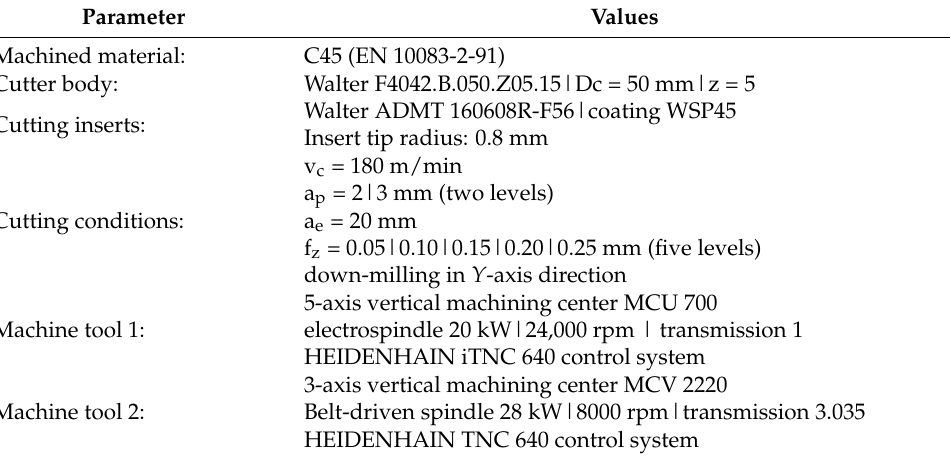
Table 3. Parameters of Case study